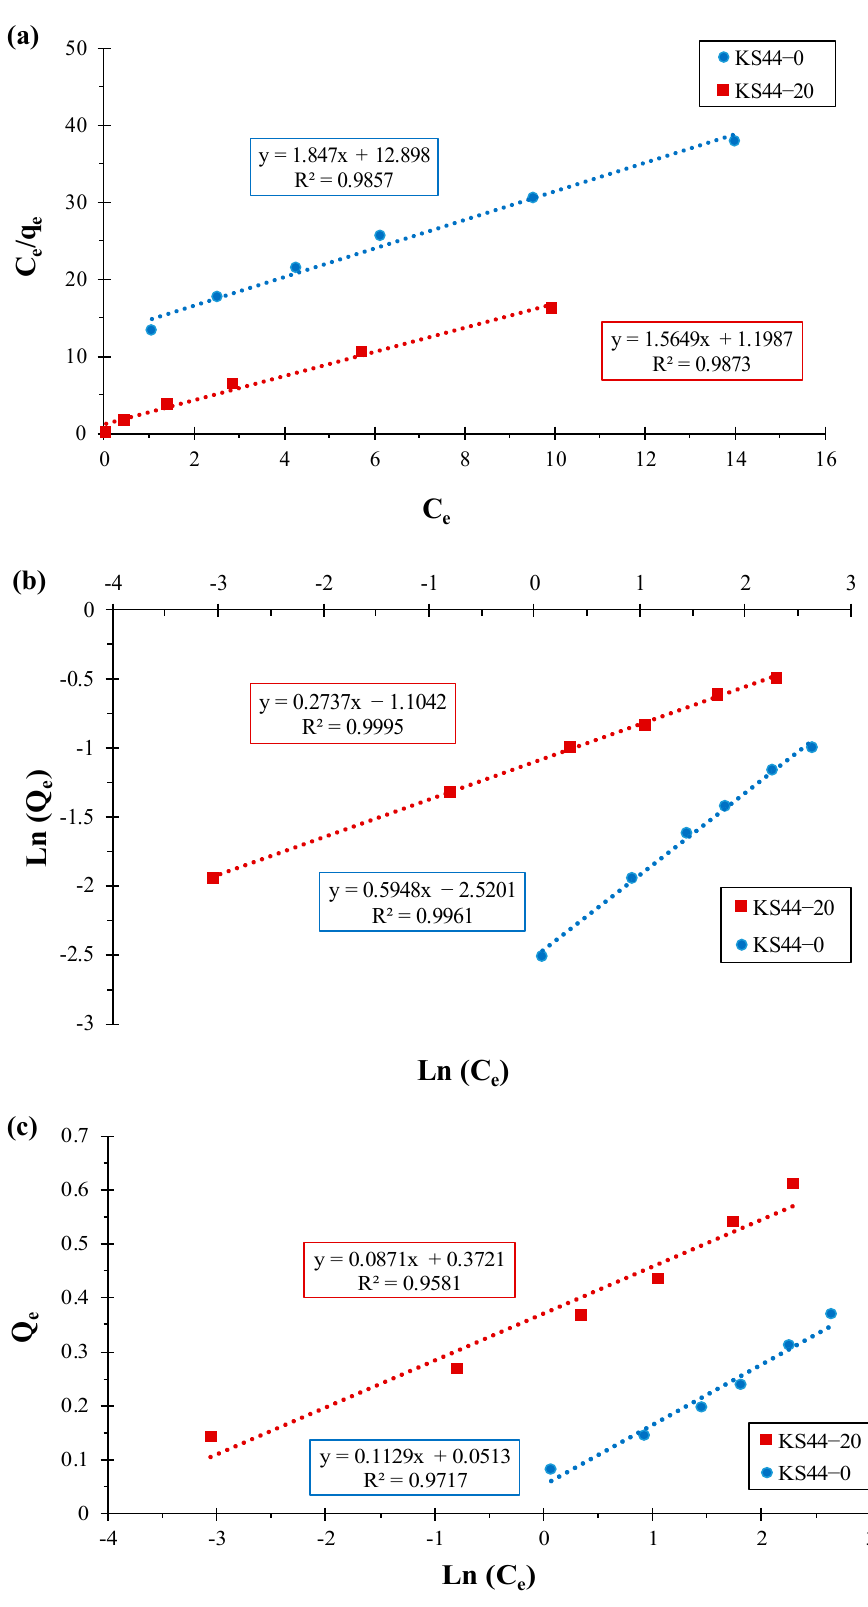
Figure 8. Transformed adsorption isotherm for ( a ) the Langmuir model, ( b ) the Freundlich model and ( c ) the Temkin model for RhB adsorption on KS44 ‐ 0 and KS44 ‐ 20 composites. Table 4. Langmuir, Freundlich and Temkin isotherm model parameters for RhB adsorption on KS44 ‐ 0 and KS44 ‐ 20 composites.